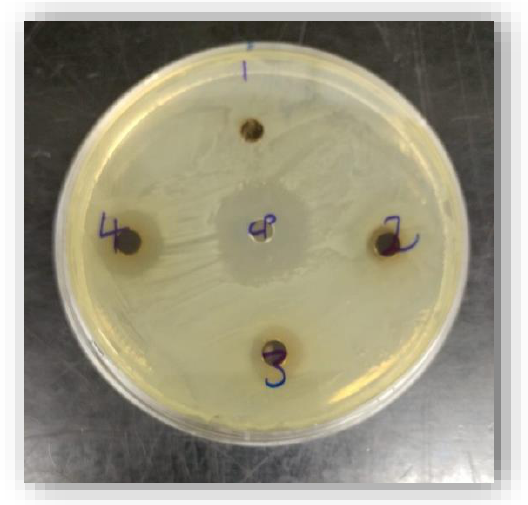
Figure 7. The zone of inhibition (ZOI) formed by green synthesized RGO-PN100 from Coleus amboinicus against the human bacterial pathogen E. coli (ATCC25922): (1) RGO, (2) RGO-PN50, (3) RGO-PN150, and (4) RGO-PN100.